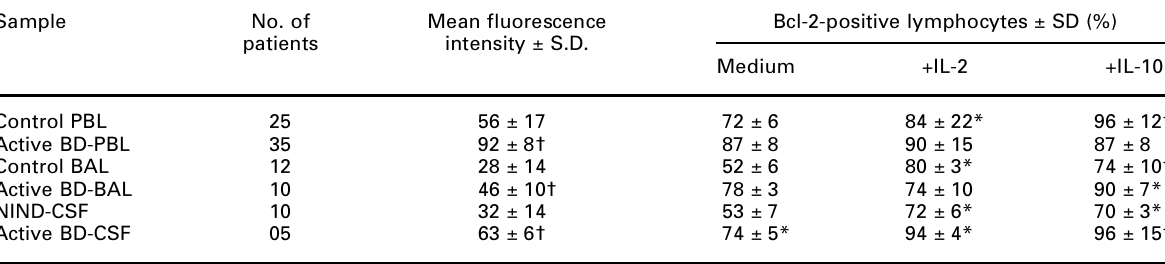
Table 2. Bcl-2 expression as mean fluorescence intensity (MFI) in peripheral blood T lymphocytes (PBMC), bronchoalveolar lavage T lymphocytes (BAL) and cerebrospinal fluid lymphocytes (CSF) from controls and active BD with pulmonary manifestations and neurological involvement